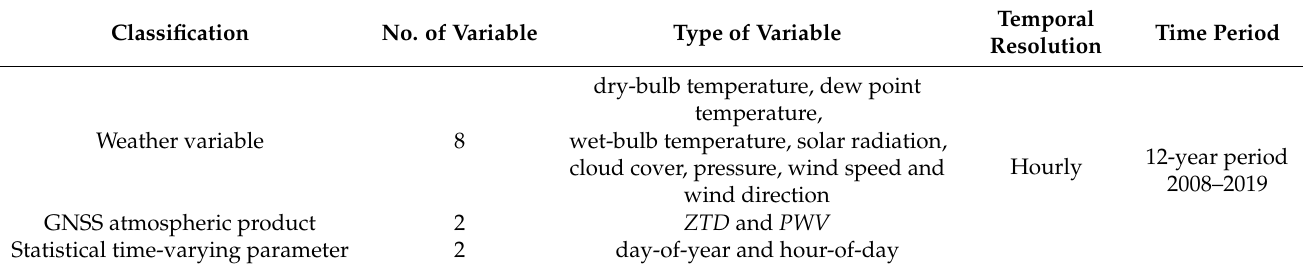
Table 1. Twelve types of variables adopted in this